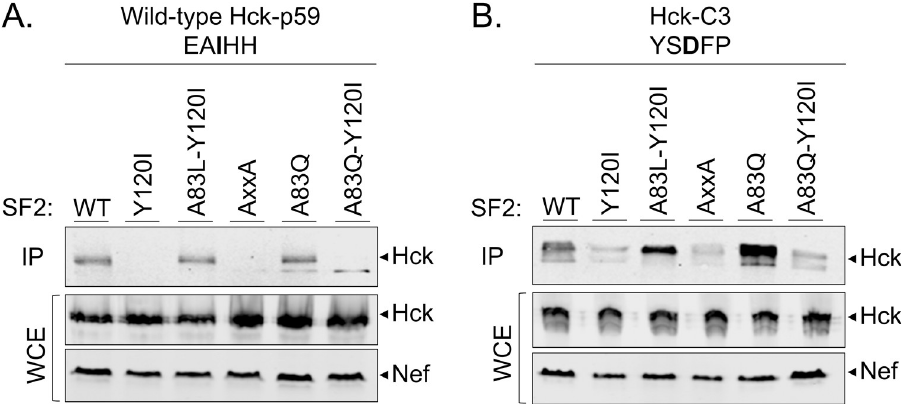
Fig 7. Role of R-clamp residues 83/120 in intracellular Hck-Nef complex formation. HEK293 cells were transfected with Myc-tagged wild-type HIV-1 M SF2 Nef (WT) or its mutants including Y120I, A83L-Y120I, P76A-P78A (AxxA), A83Q, and A83Q-Y120I) together with biotin acceptor domain-tagged wild-type Hck-p59 (WT) (A.) or its SH3 mutant Hck-C3 (B.) . The Nef-contacting RT-loop residues centered around the critical SH3 amino acid 13 (Ile in WT and Asp in C3) are shown on top of these figures. Lysates of transfected cells were subjected to anti-Myc immunoprecipitation followed by Western blotting analysis of the immune complexes using labeled streptavidin (top panels). Equal Hck and Nef expression in the total lysates was confirmed by labeled streptavidin (Hck) (middle panels) or an anti-Myc (Nef) antibody (bottom